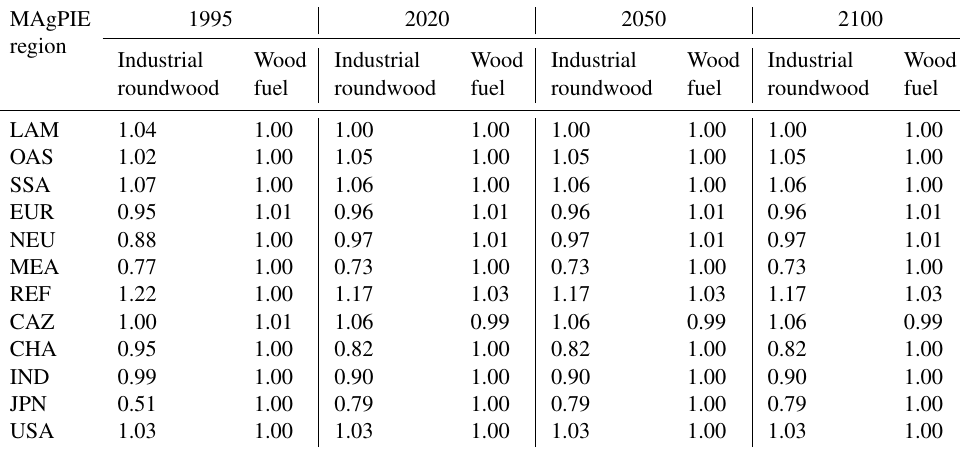
Table A3. Self-sufficiency ratios in MAgPIE for industrial roundwood and wood fuel for 1995, 2020, 2050 and 2100. MAgPIE